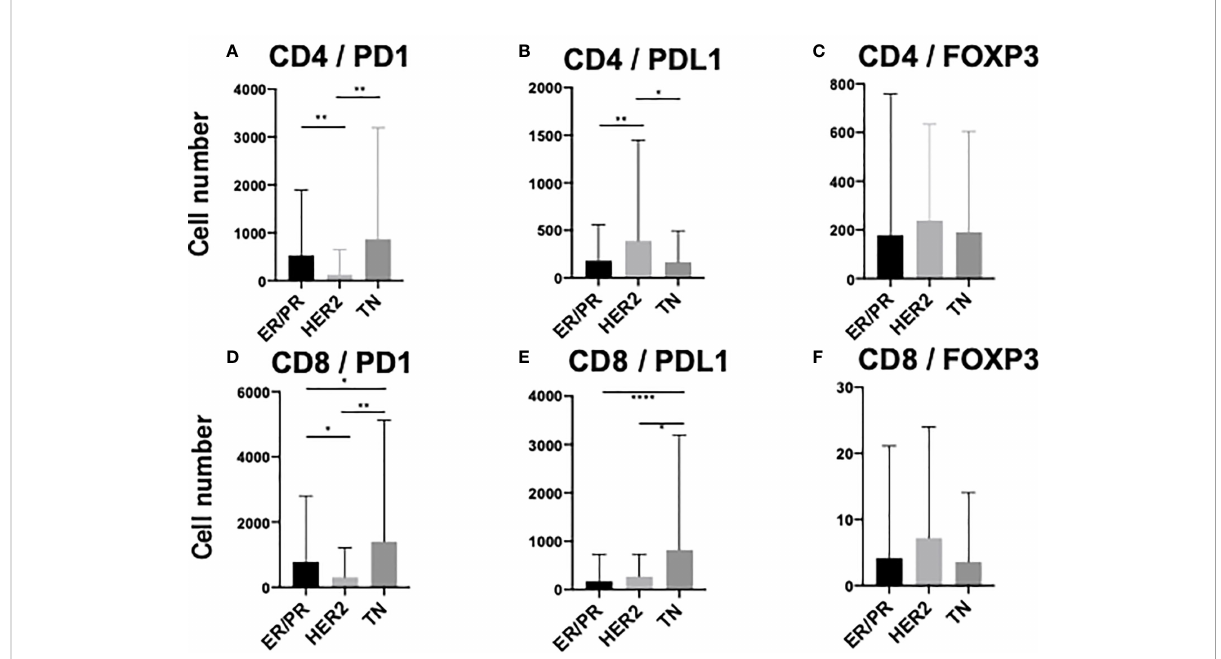
FIGURE 4 Comparison of stromal TIL (sTIL) marker double-positive cells among ER/PR, HER2, and TN subtypes. Average number of (A) CD4/PD1, (B) CD4/ PDL1, (C) CD4/FOXP3, (D) CD8/PD1, (E) CD8/PDL1, and (F) CD8/FOXP3 double-positive sTILs among each subtype (ER/PR: n=46, HER2: n=18, TN: n=22). *, **, and **** indicate p < 0.05, p < 0.01, and, p< 0.0001 respectively (One way ANOVA test and Tukey ’ s multiple comparison test). Error bars represent standard